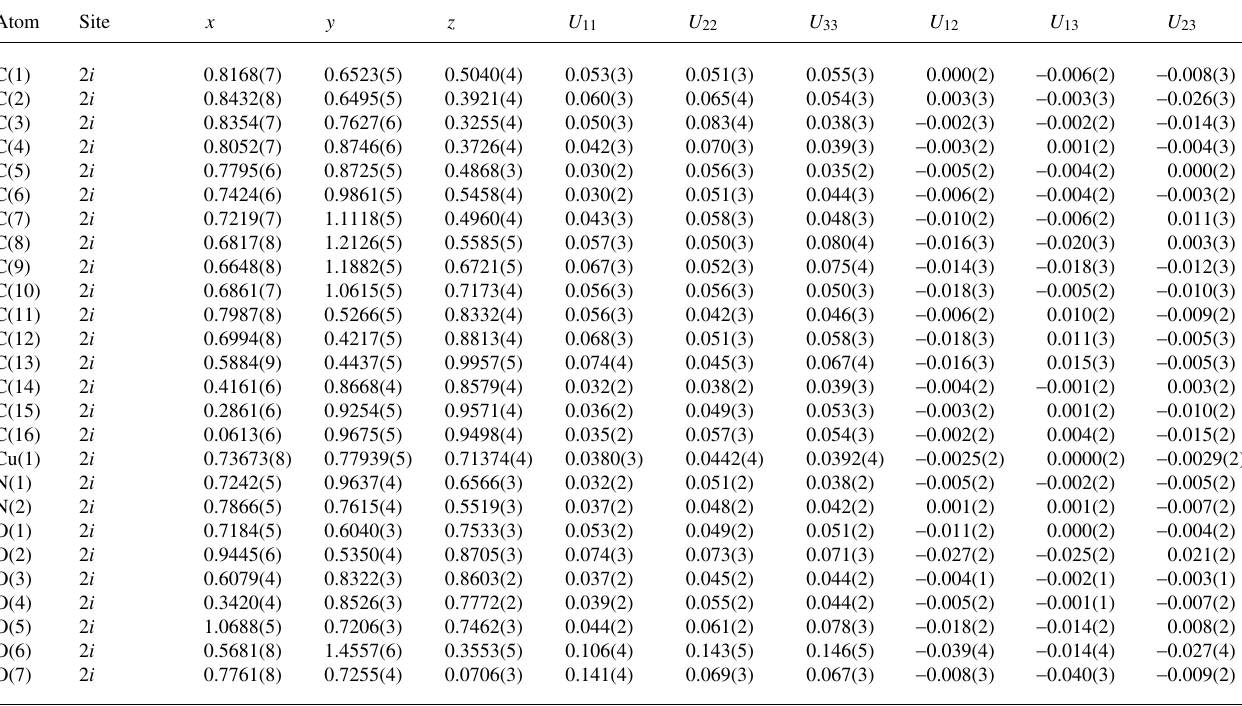
Table 3. Atomic coordinates and displacement parameters (in Å 2 )